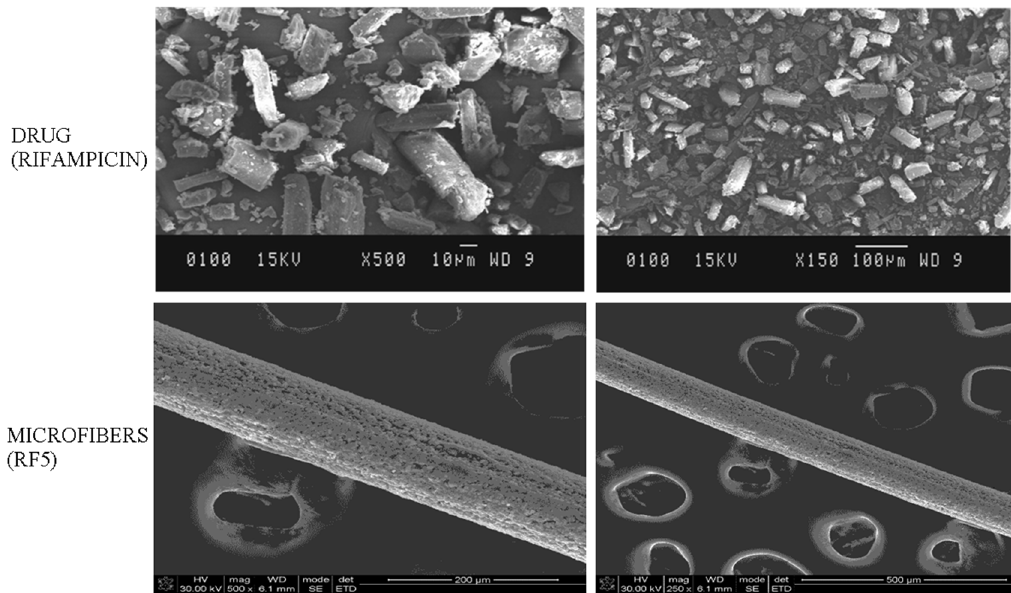
Figure 2. Morphological analysis of drug (rifampicin) and microfibers (RF5) at magnification value at 500 × and 150 × .